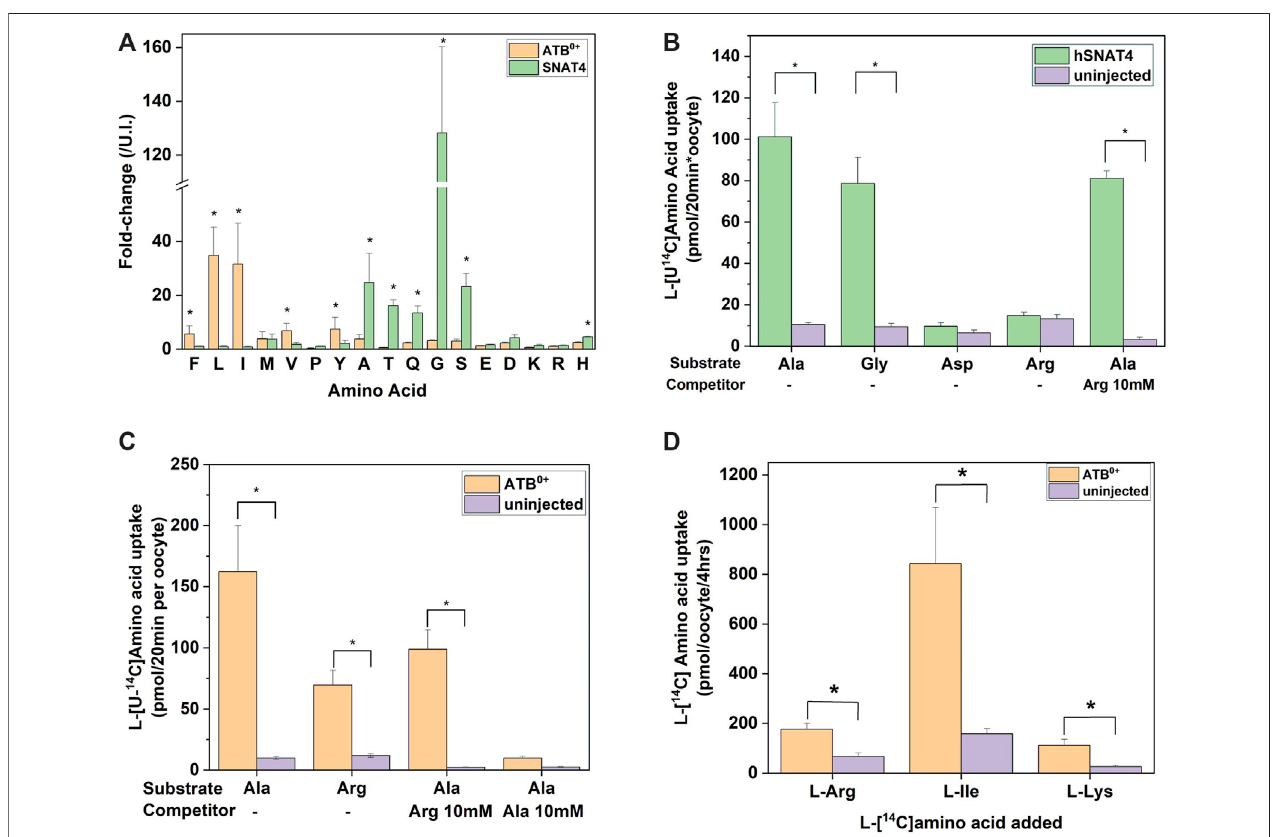
FIGURE4| AnalysisofSNAT4andATB 0+ transportactivity.Oocyteswereinjectedwith10 ngofcRNAforSNAT4andATB 0+ orremainedun-injected(controls)for a4-dayexpressionperiodinOR2 + (pH7.8). (A) Oocyteswereincubatedfor4 hinmodi fi edL-15mediumbeforesampleextractionandanalysisbyLC-MSrelativetoun- injected oocytes (U.I.). (B) Transport of [ 14 C]amino acids was measured over a time period of 20 min in SNAT4 expressing oocytes compared to non-injected oocytes. (C) Transport of[ 14 C]alanine and arginine wasmeasured over atime period of20 min in ATB 0+ expressing oocytes and compared to non-injected oocytes. Where indicated, alanine uptake was challenged by addition of 10 mM unlabelled arginine or alanine. (D) Transport of [ 14 C]arginine, isoleucine and lysine was measured over a time period of 20 min in ATB 0+ expressing oocytes and compared to non-injected oocytes. * Indicates a difference in the means between samples at the p < 0.05 level using a paired t -test as calculated from the absolute mass spectrometer raw values. The fi gures are a representative example of 3 experiments with n (cid:2) 10 oocytes per